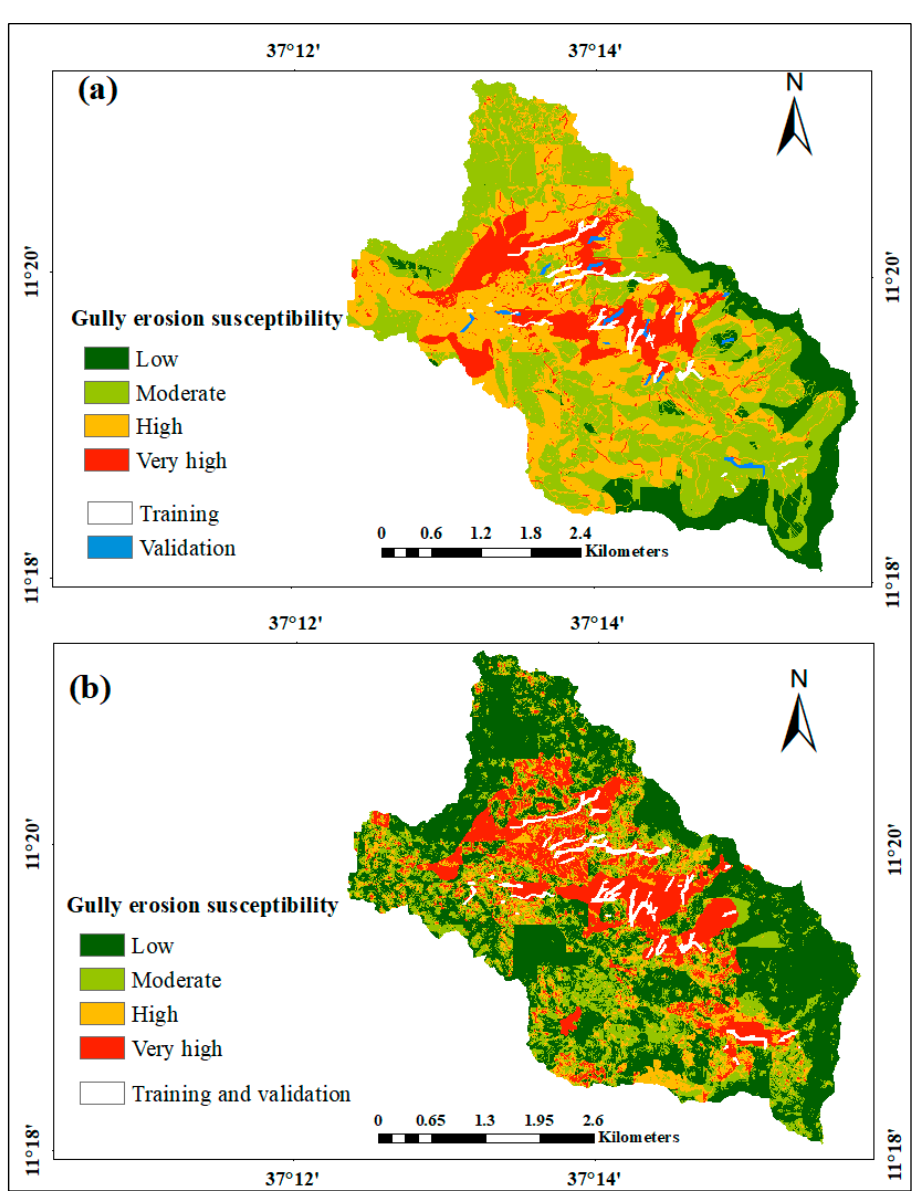
Figure 5. Gully erosion susceptibility map using ( a ) frequency ratio and ( b ) random forest models: for this model, the training and validation gully polygon takes the same white color as the model that classifies the training and validation data internally.